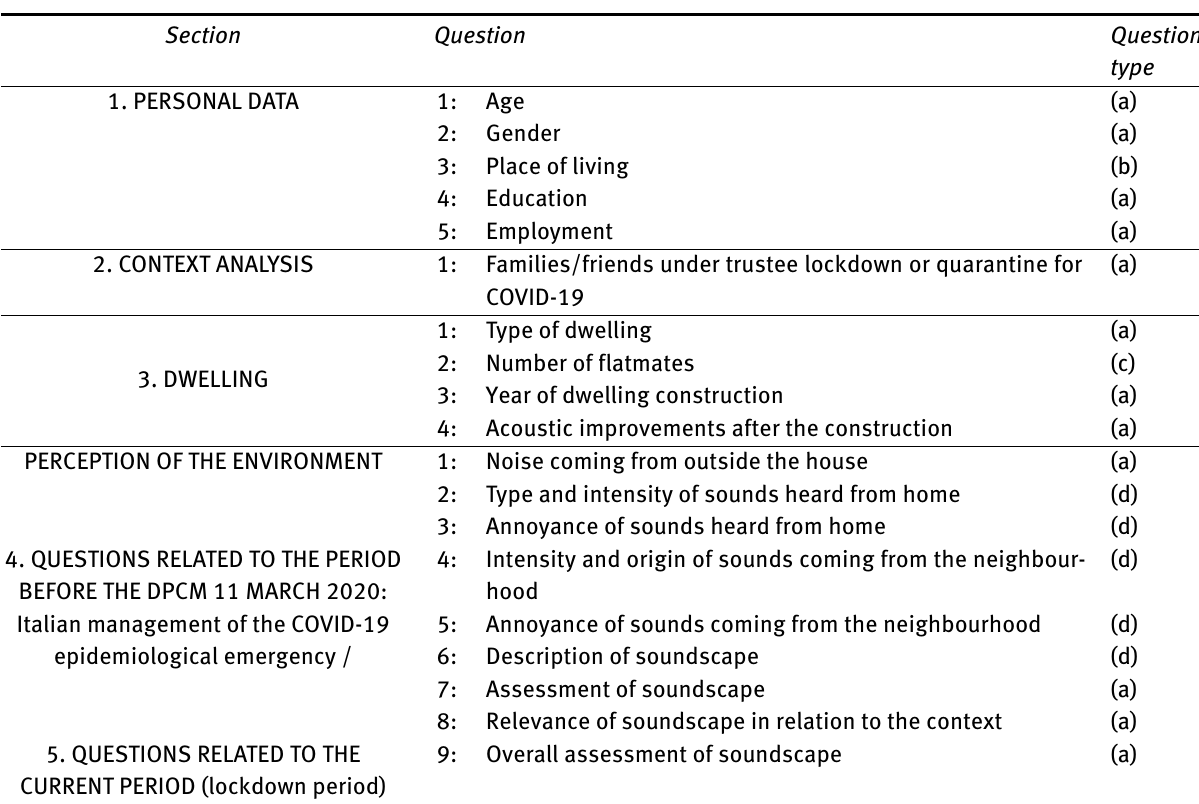
Table 1: Contents of the